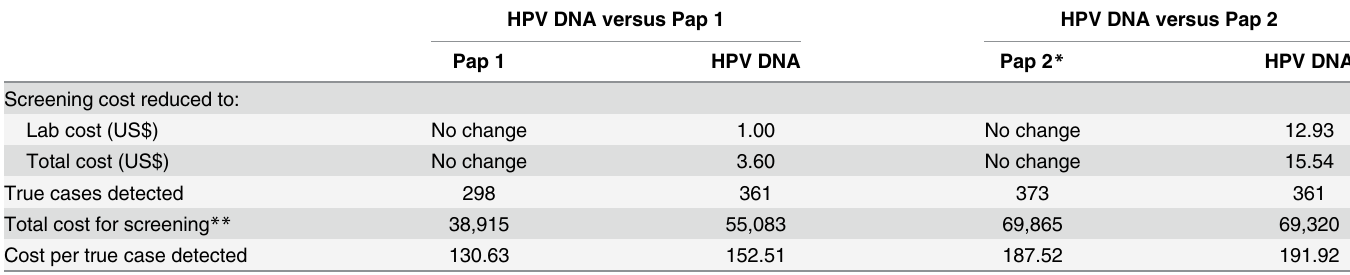
Table 6. Threshold analysis comparing the costs of HPV DNA testing to actual and hypothetical Pap screening (Functional Limit